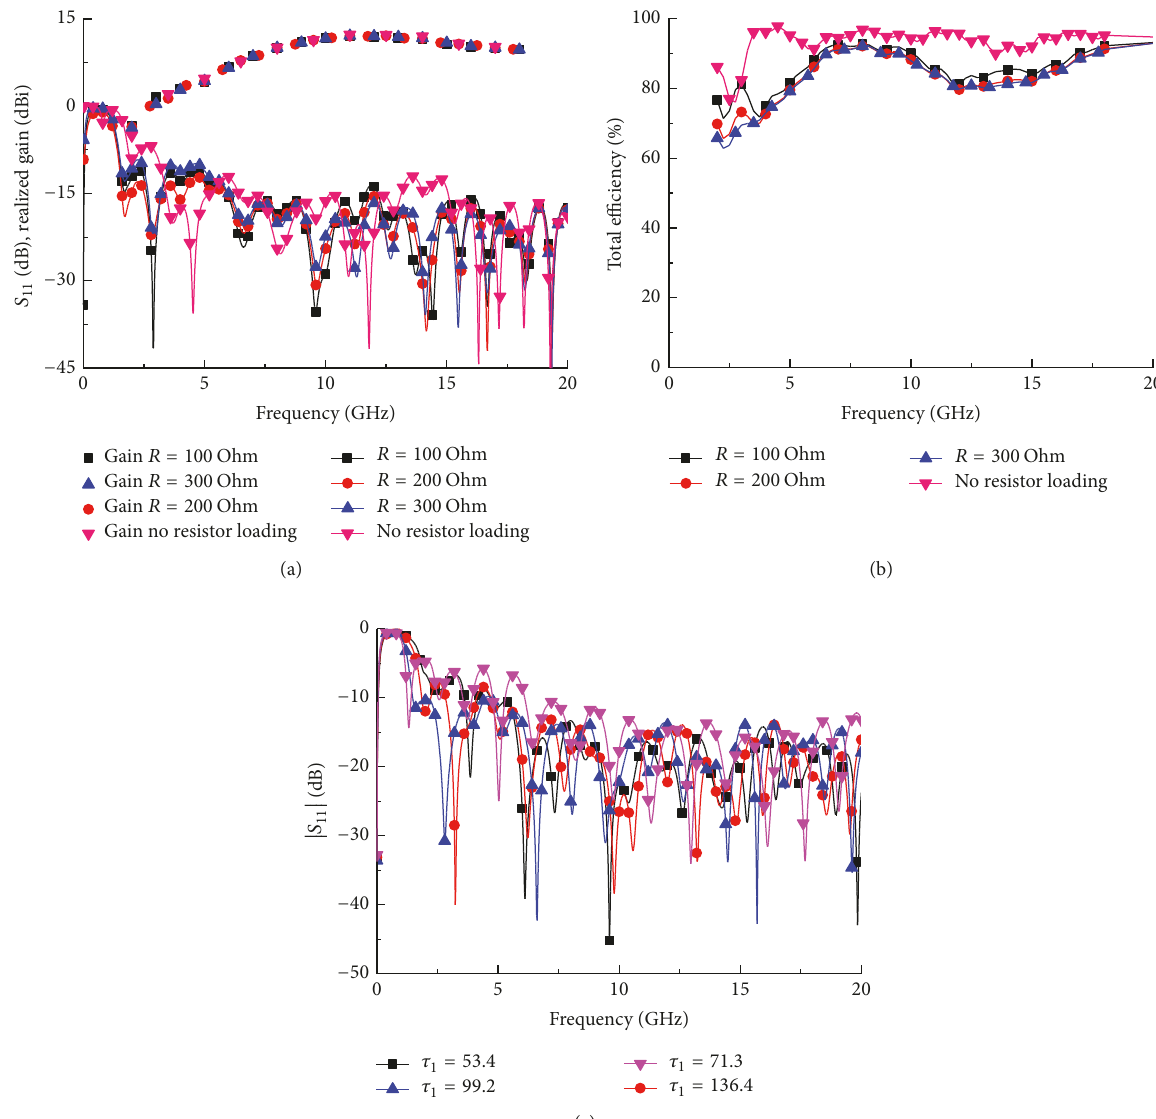
Figure 2: Effect of 𝑅 and 𝜏 1 . (a) Simulated 𝑆 11 and realized gain with different value of 𝑅 , (b) simulated total efficiency with different value of 𝑅 , and (c) simulated 𝑆 𝜏 11 with different value of 1 .